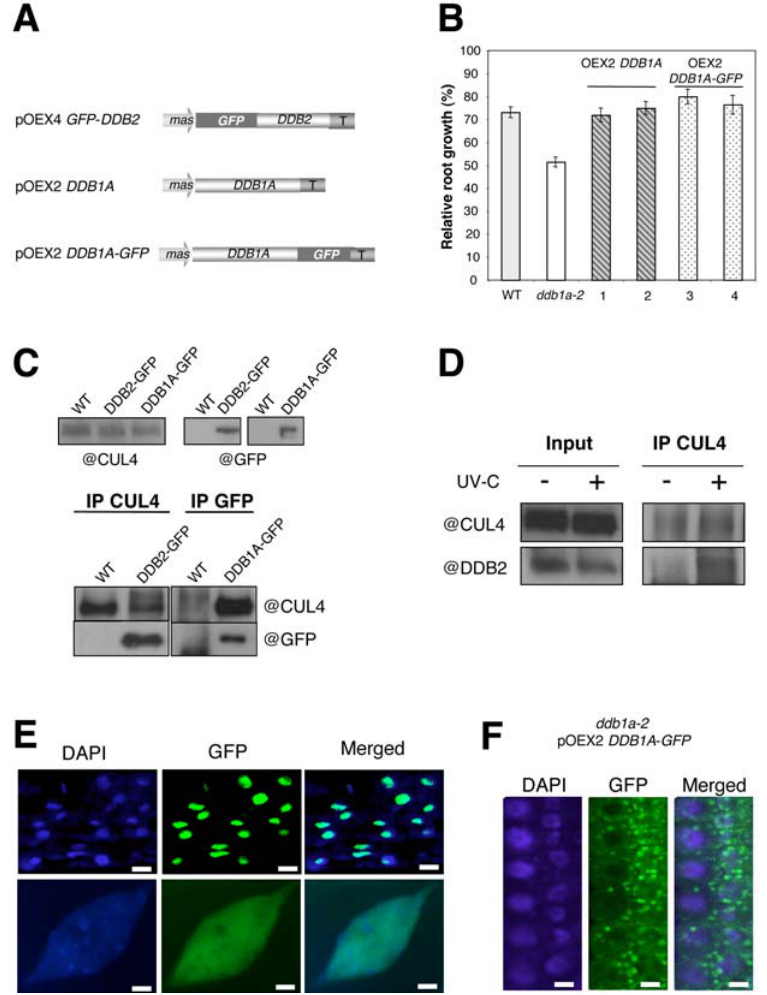
Figure 5. DDB1A and DDB2 interaction with CUL4 and their subcellular localisation. (A) Schematic representation of the constructs (mas: mannopine synthase; GFP: Green Fluorescent Protein; T: nos terminator). (B) Root growth assays showing complementation of ddb1a-2 with either DDB1A or DDB1A-GFP ectopically expressed proteins. (C) In vivo pull down of CUL4 with DDB1A and DDB2 proteins. WT, pOEX4 GFP-DDB2 and ddb1a- 2 pOEX2 DDB1A-GFP plants were used for immunoprecipitation assays using either anti-CUL4 (Bernhardt et al., 2006) or anti-GFP antibodies. WT plants were used as controls. (D) In vivo pull down of CUL4 complex upon UV-C exposure. WT plants were used for immunoprecipitation assays using anti- CUL4 antibody. CUL4 and DDB2 were detected before ( 2 ) and 15 min upon UV-C exposure ( + ). (E) Localisation of GFP-DDB2 fusion protein in root cells using confocal microscopy (Bar=50 m m) and immunolocalisation in root cells (Bar=5 m m). (F) Localisation of DDB1A-GFP fusion protein in root cells using confocal microscopy (Bar=25 m m). All pictures are representative of 3 different experiments using independent transgenic